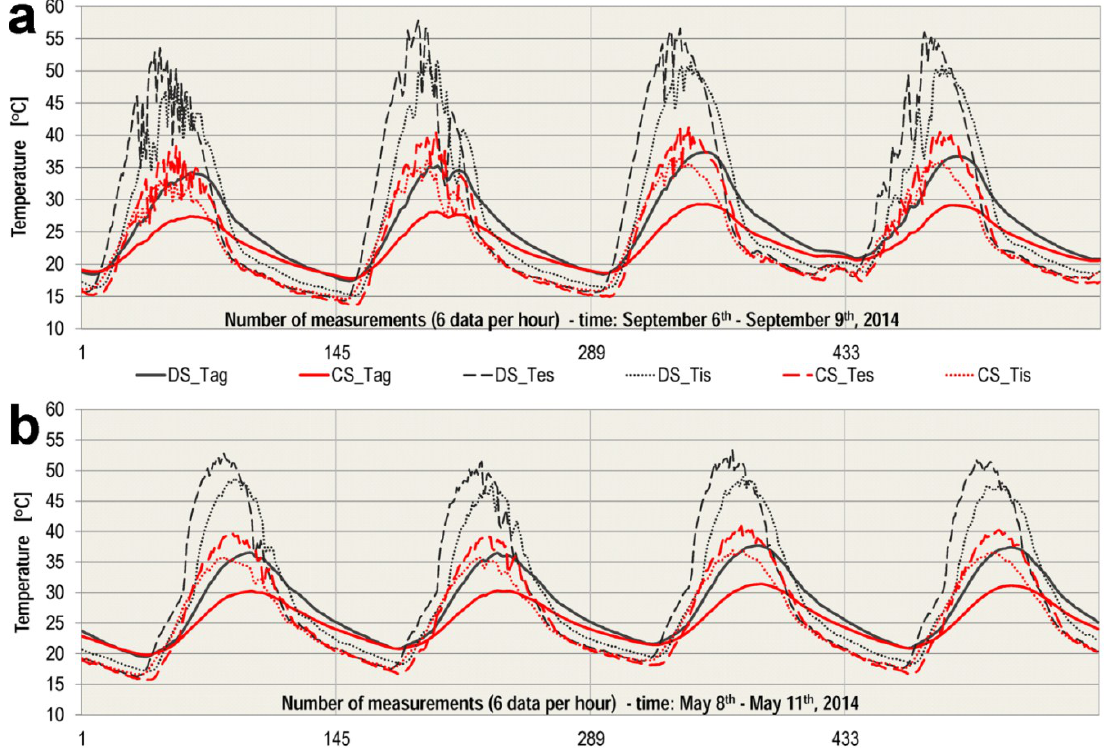
Figure 6. Indoor thermal behavior of the test-rooms before the implementation of the Cool Shading systems in TR2. ( a ) Summer conditions; ( b ) Spring conditions.